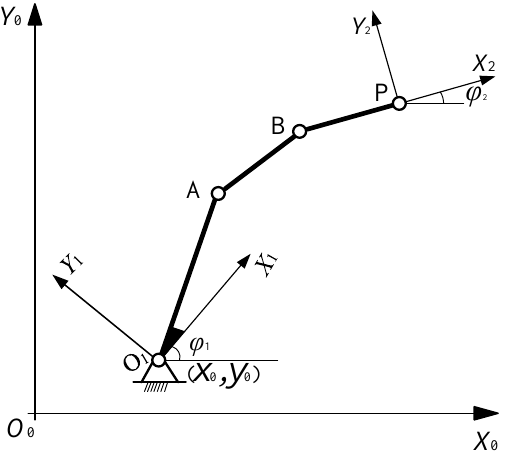
Figure 5. Establishment of coordinate systems of 3R open chain.